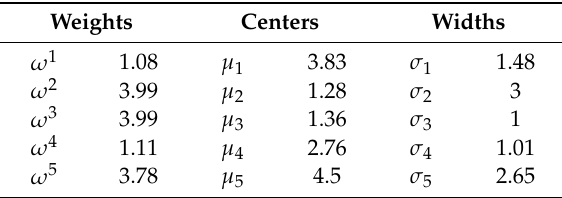
Table 3. Neural network